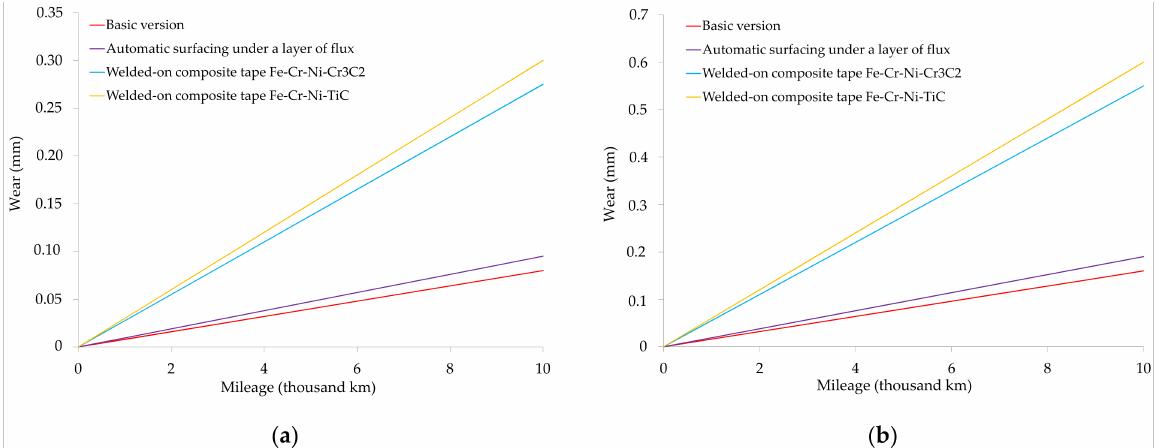
Figure 4. Diagrams of wear of the CBRTB after interaction with the center plate of the body in function of the mileage: ( a ) an empty freight car; and ( b ) a full load of a freight car.